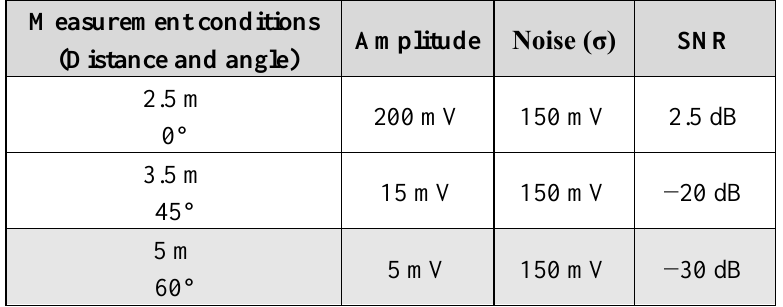
Table 2. SNR levels in the output of the receiver.